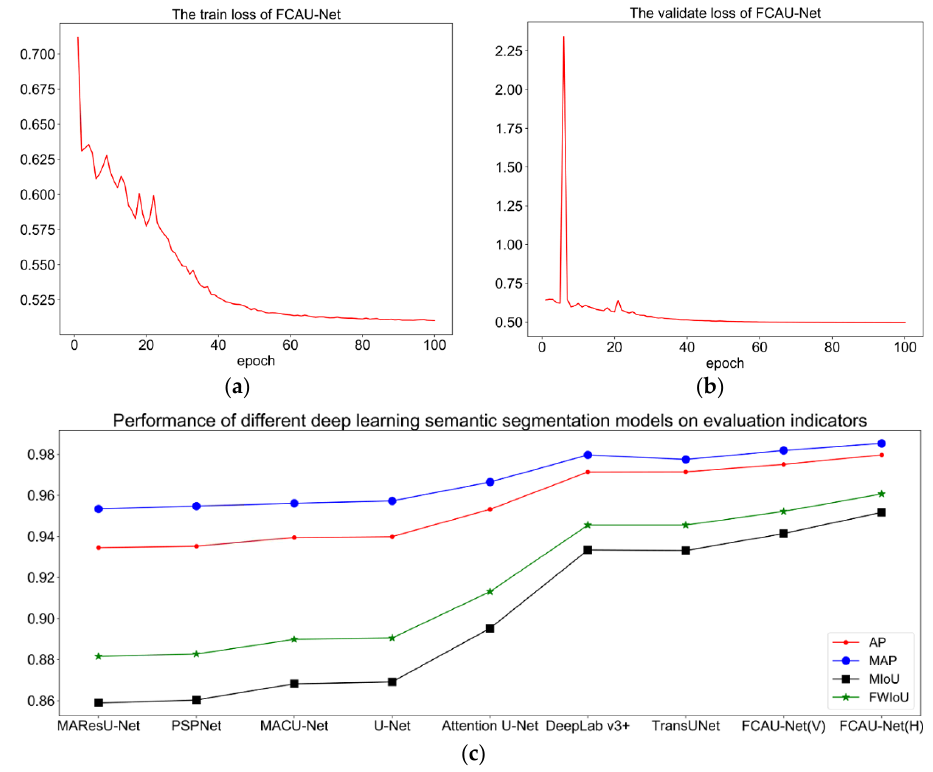
Figure 12. The loss and accuracy values of the FCAU-Net. ( a , b ) are the loss values on the training and validation sets, respectively. ( c ) is the accuracy values of different approaches.